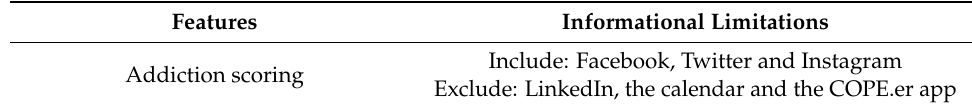
Table 6. An example for specifying informational limitations.